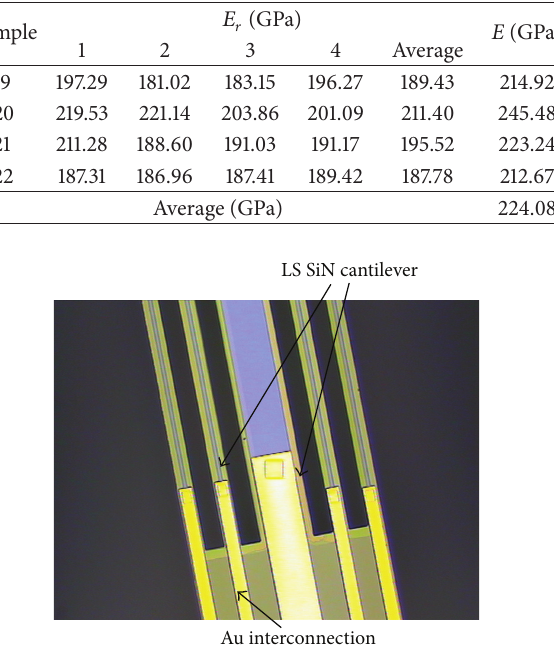
Figure 4: Cantilever structure made from LS SiN as the structural